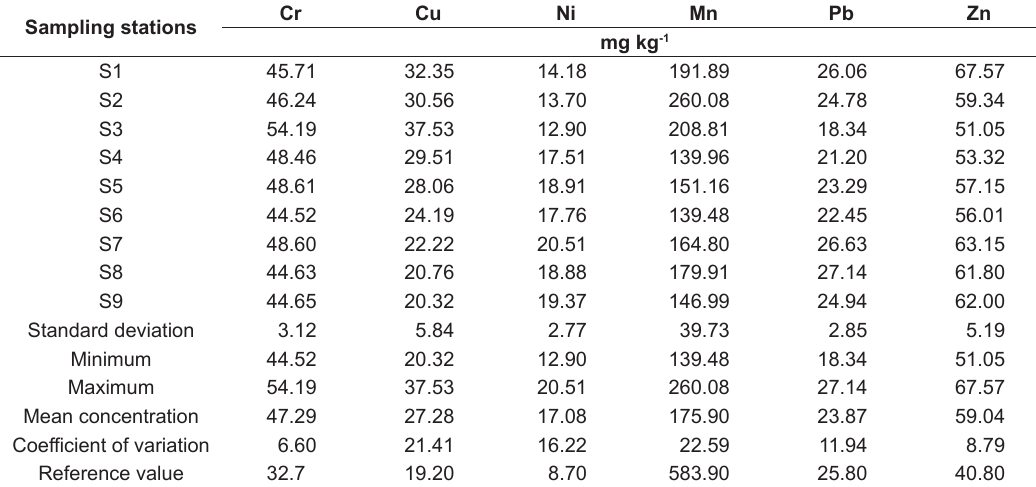
Table 2. Spatial variation of concentration of Copper (Cu), Chromium (Cr), Nickel (Ni), Lead (Pb) and Zinc (Zn) (mg kg -1 ) in sediments of the Itupararanga Reservoir (São Paulo State, Brazil), standard deviation, coefficient of variation and regional reference values (RRV) (Cardoso-Silva et al.,